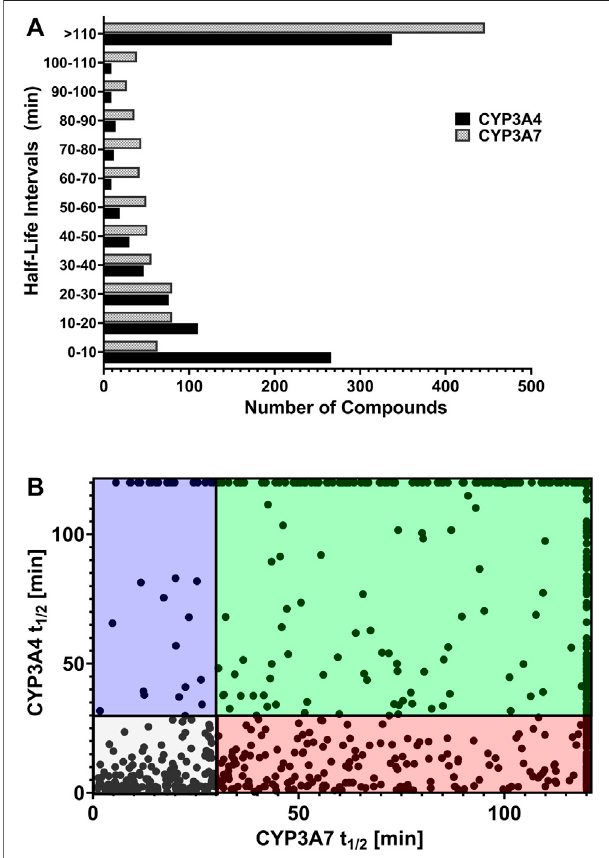
FIGURE 6 | (A) Distribution of substrates against CYP3A4 and CYP3A7 based on half-life obtained in substrate depletion assay. (B) Correlation of t 1/2 between substrates in CYP3A4 and CYP3A7 substrate depletion assays. Blue box: CYP3A7 preferred substrates (t 1/2 ≤ 30 min for CYP3A7 and > 30 min for CYP3A4). TheCYP3A7-selective substrates are shown at the top boundary line (t 1/2 ≤ 30 min for CYP3A7 and > 120 min for CYP3A4; see details in text). Red box: CYP3A4 preferred substrates (t 1/2 ≤ 30 min for CYP3A4and > 30 minforCYP3A7).Greenbox: Weak substrates (t 1/2 > 30 min for both enzymes). Gray box: Common substrates (t 1/2 < 30 min for both